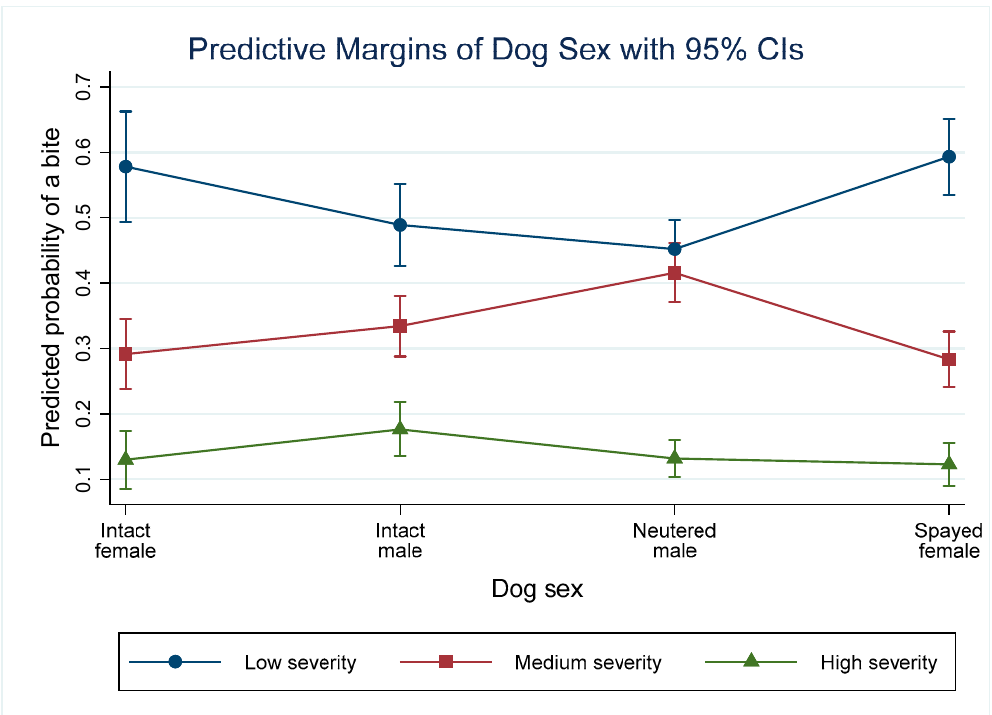
Figure 3. Predictive margins for the different severity incidents depending on the sex of the dog and controlling for other variables in the model.